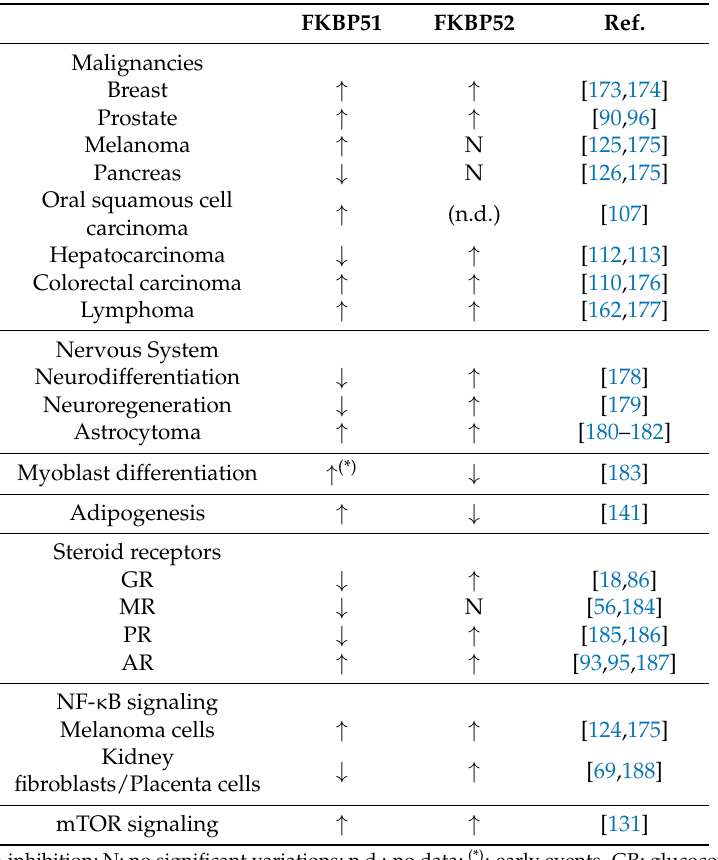
Table 1. Effects of FKBP51 and